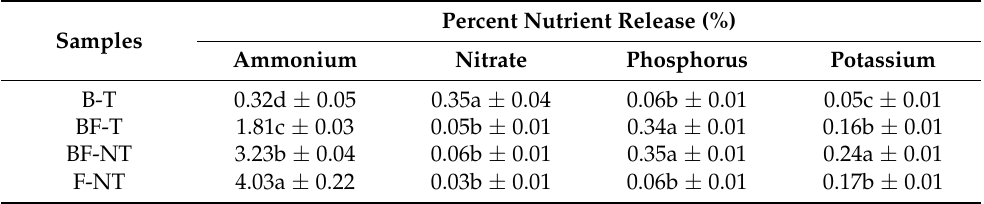
Table 3. Percent soluble nutrient release from different treatments during water incubation on the 30th day.